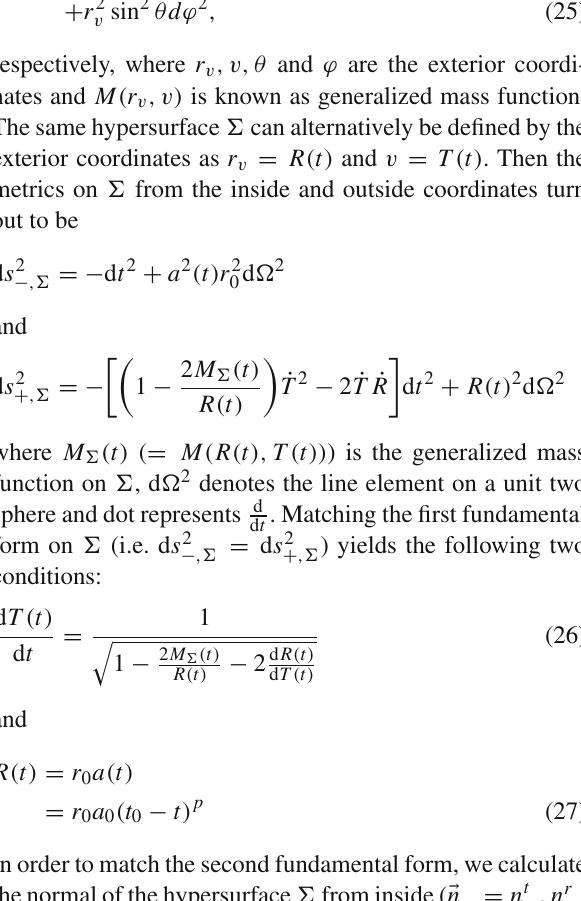
by different choices of p , only the rates of the changes. We have presented here two specific examples with p = 0 . 5 and p = 0 .